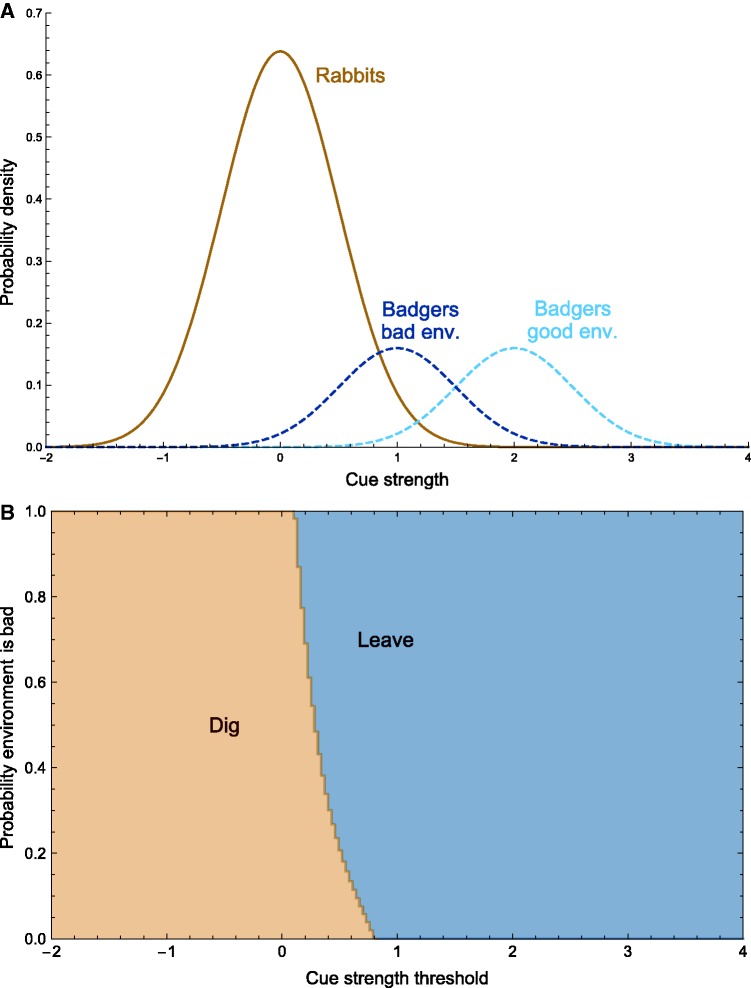
The two environments differ in how loud badgers are. (A). In the good environment, badgers are easier to detect than they are in the bad environment. The optimal decision rule is computed using dynamic programming and illustrated in the lower panel (B). The decision about whether to dig depends on the value x of the cue and the subjective probability that the environment is bad. A curve separates the region in which one should dig (tan) from the region in which one should not (blue)